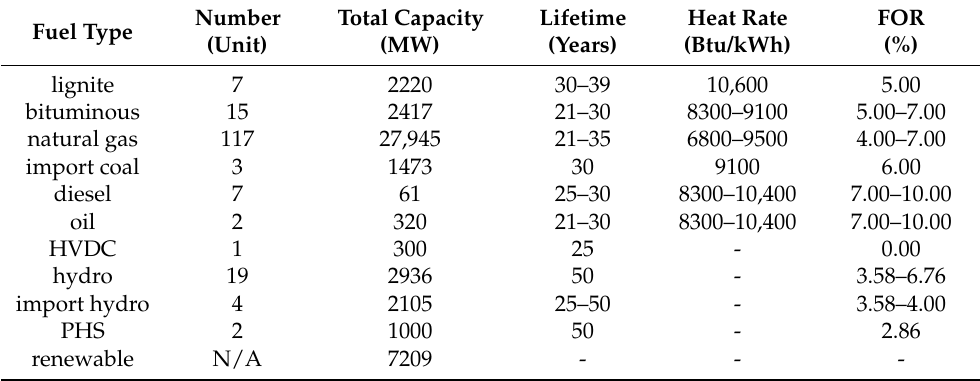
Table A3. Thailand’s power generation system as of December 2020.